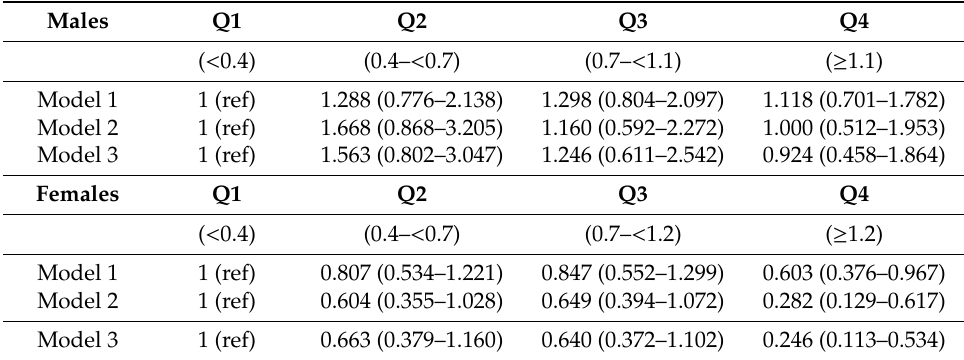
Table 4. Adjusted odds ratios (ORs) and 95% confidence intervals (CIs) of sarcopenic obesity by quartiles of ω 3FA